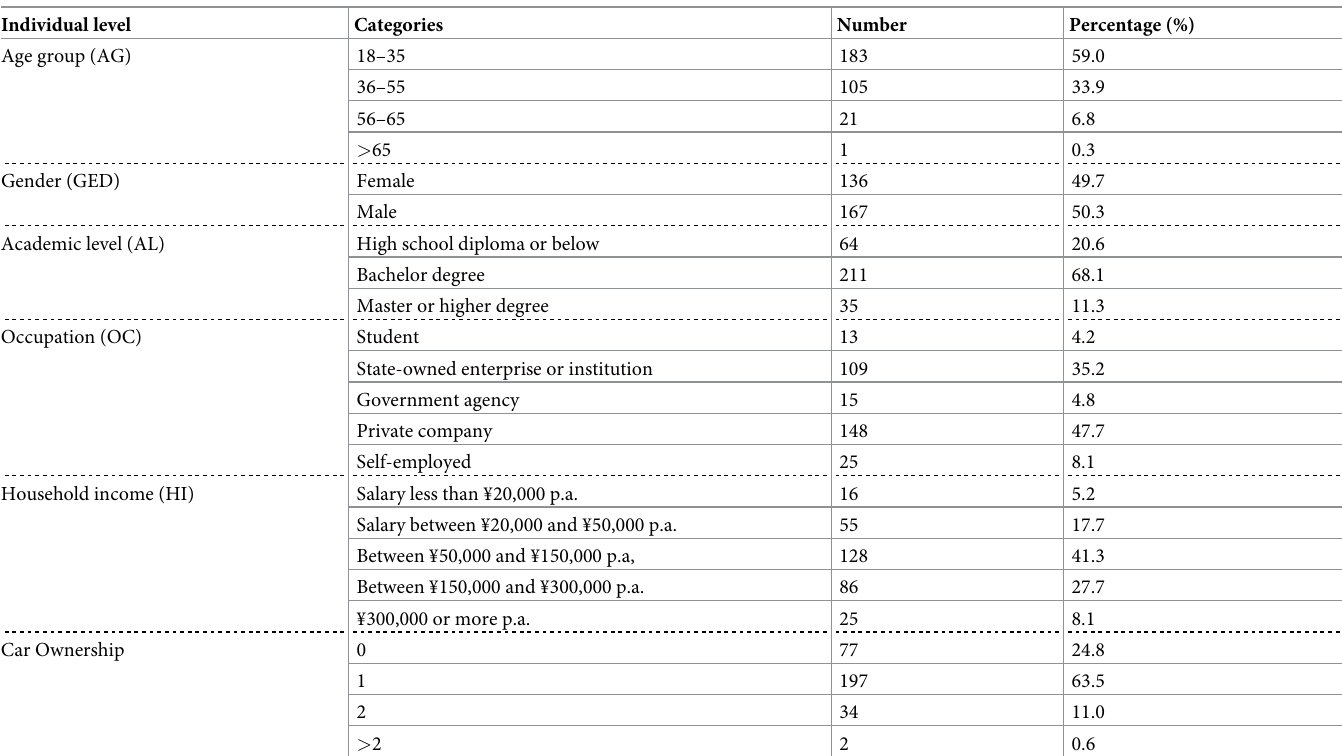
Table 2. Sample information (N = 310).